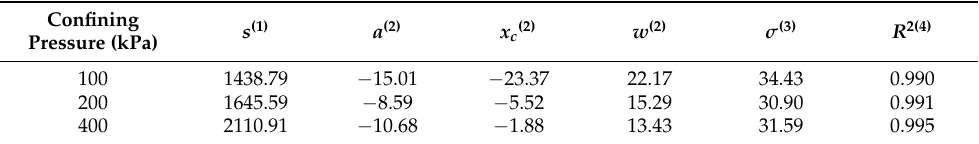
Table 5. Parameters obtained from the Gaussian curve analysis of solidified/stabilized gold tailings with different confining pressures.